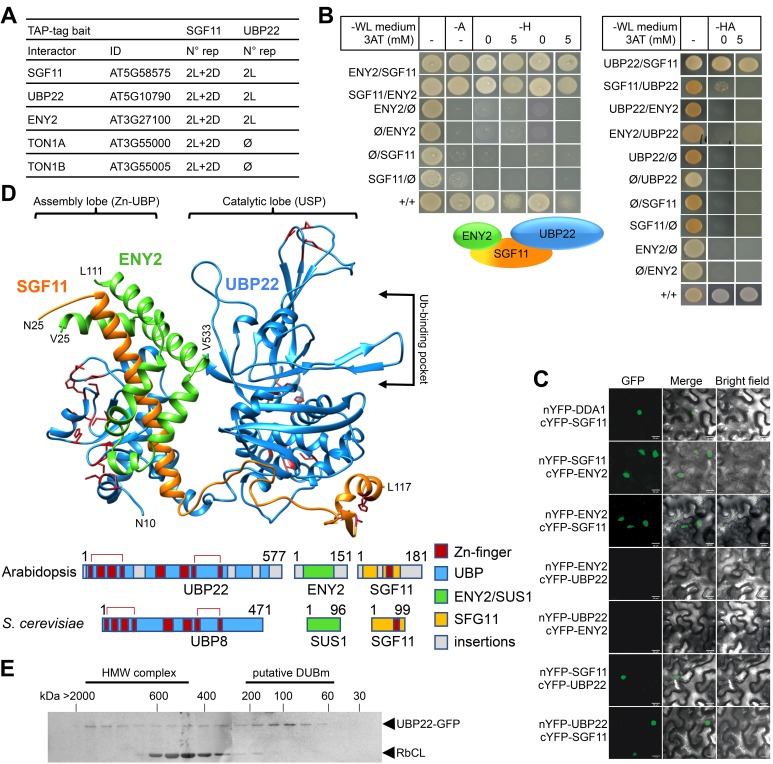
SGF11 physically associates with ENY2 and UBP22 to form an Ubp8-like DUBm.(A). TAP identification of UBP22 and ENY2 as SGF11-associated proteins. The table summarizes the whole set of detected proteins in each assay, including two independent replicates of dark (D) or light (L) grown cells using SGF11 as bait, and two independent biological replicates of light-grown cells when using UBP22 as a bait. (B) Yeast two-hybrid analysis of physical association between SGF11, UBP22 and ENY2 showing dual association of SGF11 with the two other DUBm components. (C) BiFC analysis of SGF11 interaction with UBP22 and ENY2 in planta. Merged images of GFP (left) and bright field (right) channels are shown (middle). Ø, empty vector. (D) Top, modeled structure of the Arabidopsis UBP22-SGF11-ENY2 complex. Bottom, representation of domain similarities in the Arabidopsis and S. cerevisiae proteins (colored as indicated, gray areas reveal insertions that could not be modeled). The position of predicted Zn-finger domains in UBP22 and SGF11 is indicated in dark red in both panels. Red brackets above the schematized sequences link domains involved in the same Zn-finger. (E) Size-exclusion chromatography analysis of UBP22-GFP complex size in protein extracts from UBP22::UBP22-GFP Arabidopsis seedlings. Fractions were analyzed by anti-GFP immunoblot. Highly abundant Ribulose bisphosphate carboxylase Large Chain (RbCL) bands were also non-specifically detected. The size of molecular-weight standard eluted in the same conditions is shown.10.7554/eLife.37892.016Figure 4—source data 1.Detailed TAP protein identification.10.7554/eLife.37892.017Figure 4—source data 2.pdb of the modeled At-UBP-ENY2-SGF11 complex structure.